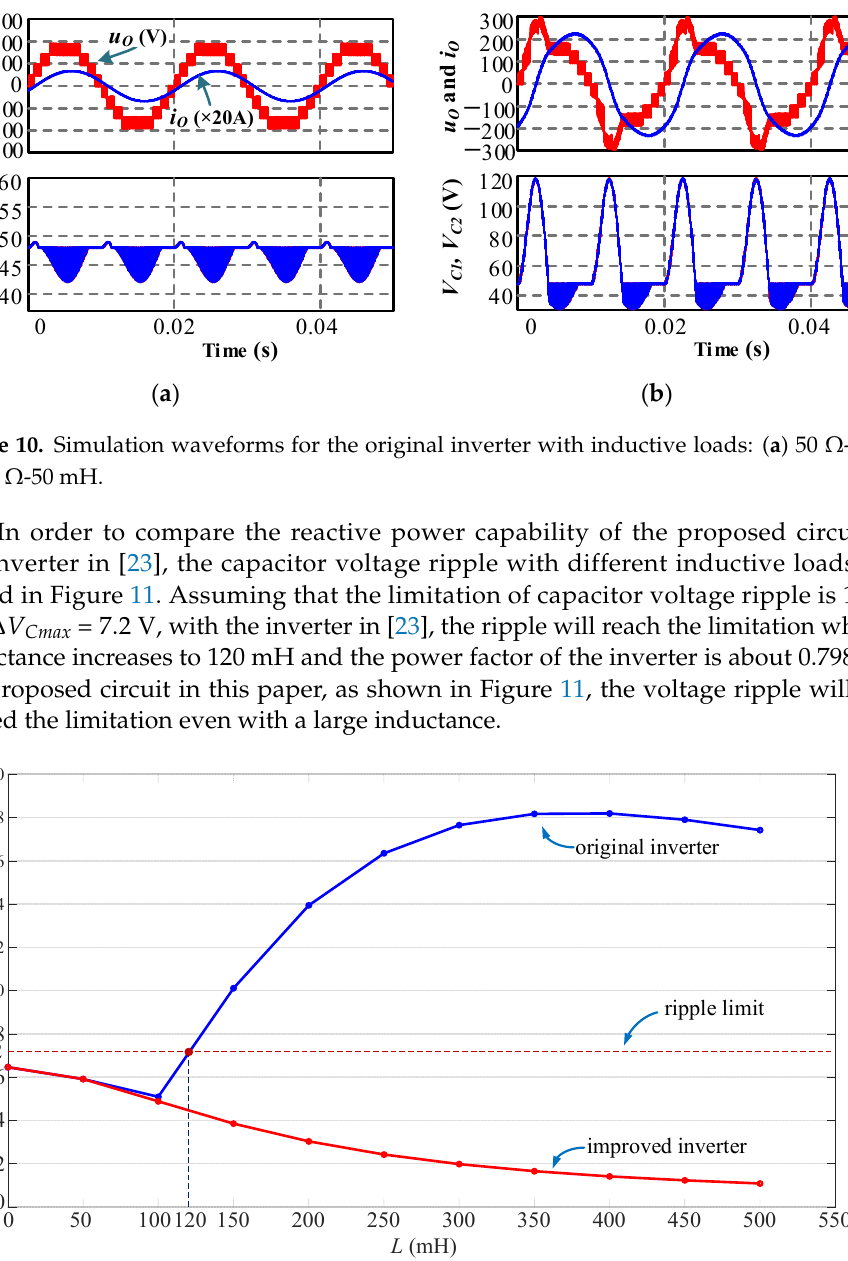
Figure 9. Simulation waveforms for the optimized inverter with inductive loads: ( a ) 50 Ω -50 mH; ( b ) 10 Ω -50 mH.